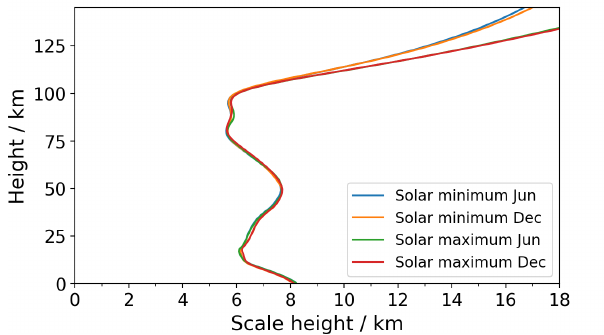
Figure 4. Atmospheric scale heights calculated using WACCM-X temperatures to give a